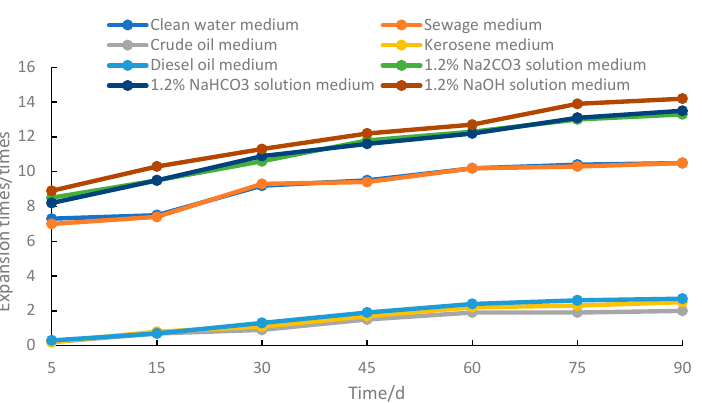
Figure 11. Comparison of expansion ratios of particles after immersion in various environments.